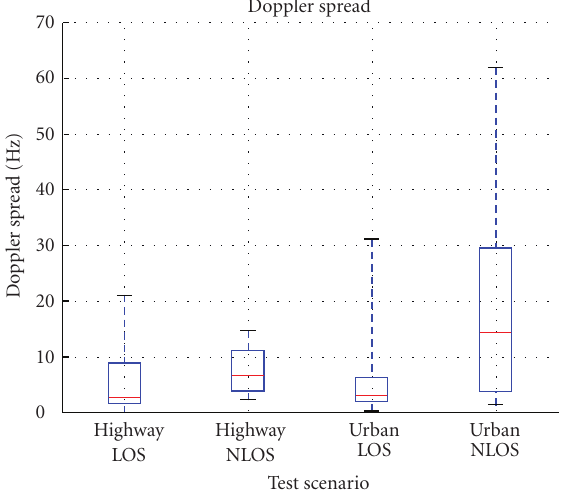
Figure 6: Comparison of Doppler spread for various scenarios.